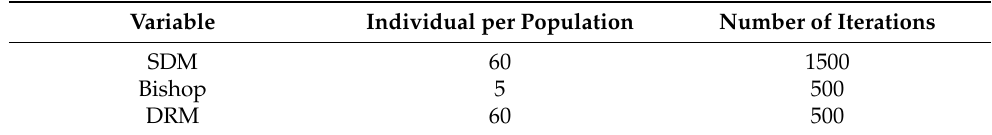
Table 4. Selection of GA variables for each